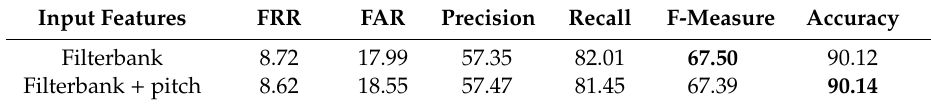
Table 15. Performance Comparison of APED systems before and after adding pitch features. Input